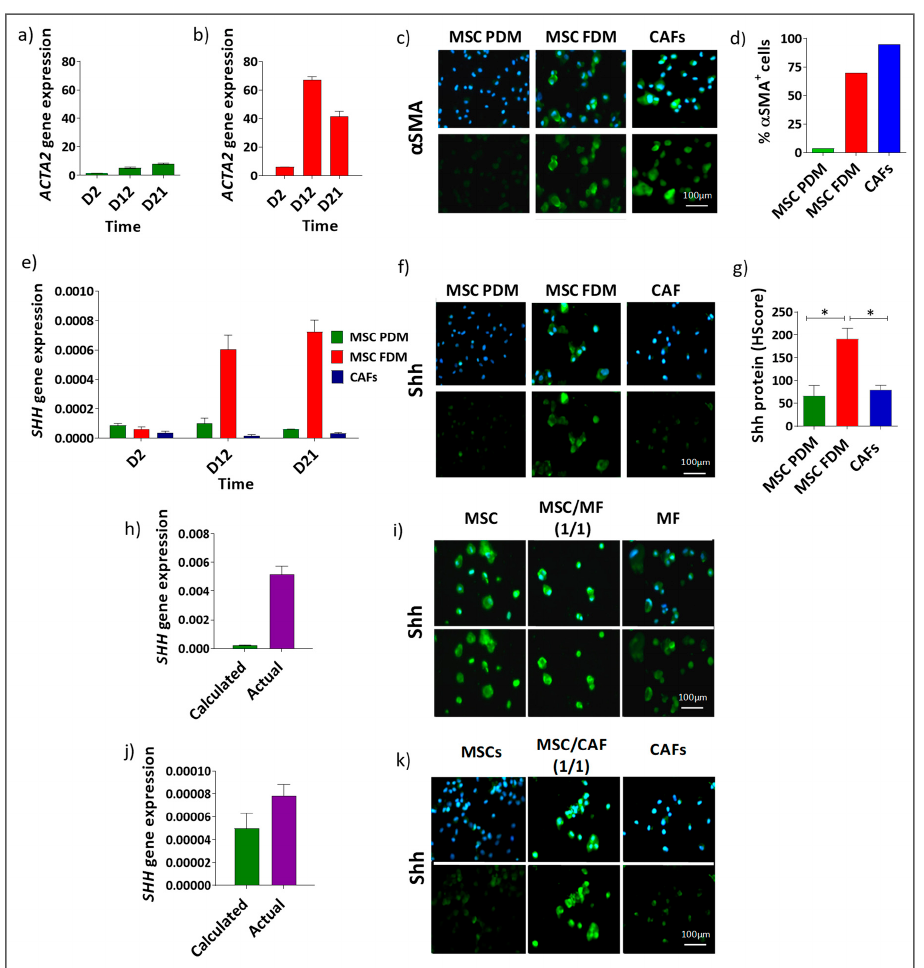
Figure 2. ( a , b , c , d ) Shh is upregulated in mixed populations of α SMA + and α SMA − mesenchymal cells: All the representative images in this figure ( c,f,i,k ) show α SMA − cells in the column on the left; α SMA + / α SMA − mixed population in the central column and α SMA + cells in the column on the right. ACTA2 gene expression in MSCs grown in PDM (a) and FDM ( b ). ( c ) Representative images of α SMA expression in MSCs grown in PDM ( α SMA − cells) or FDM ( α SMA + / α SMA - mixed population), or CAFs grown in FDM ( α SMA + cells). ( d ) Percentage α SMA + and α SMA − cells after 21 days of culture. Analysis of Shh gene ( e ) and protein ( f and g ) expression in the same 3 cell models (* p < 0.05 one-way ANOVA multiple comparison test). ( h , i , j , k ) Shh expression in in vitro models of α SMA − / α SMA + mixed populations. α SMA − cells (MSCs) were mixed at a 1:1 ratio respectively with two different α SMA + population (MSCs treated with TGF β ) ( h and i ) and CAFs ( j and k ). Data were analysed by comparing the actual SHH gene expression detected in these in vitro mixed population models with the calculated average of SHH gene expressions observed in the α SMA − and α SMA + cells grown separately in the same experiment. Gene ( h and j ) and protein ( i and k ) expression confirmed the increased expression of Shh in α SMA − / α SMA + mixed populations.